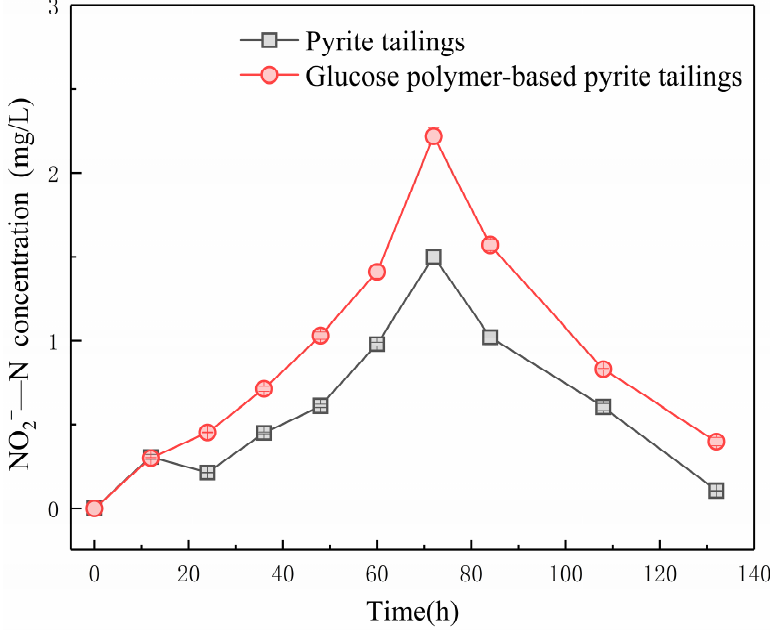
Figure 5. Variation diagram of NO 2 − -N concentration in denitrification system before and after pyrite tailings coating.